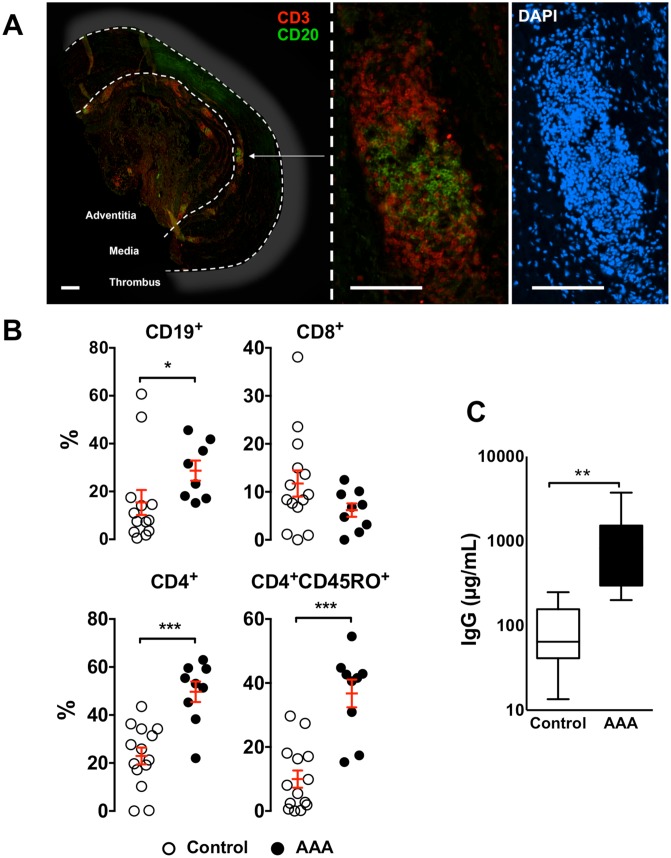
Organized Tertiary Lymphoid Structures in human Abdominal Aortic Aneurysm.(A) Representative immunohistochemical staining of CD3+ T cells (red), CD20+ B cells (green) and nuclei (DAPI, blue) performed on human AAA cross-sections (scale bar = 1 mm). (B) Flow cytometry analysis of the percentage of CD19+ B cells, total CD8+, CD4+and memory (CD4+CD45RO+) T cells in adventitia from AAAs (n = 9) or control aortas (n = 14). (C) Box plot showing the total IgG levels in conditioned medium prepared from adventitial tissues of AAAs (n = 14) and control aortas (n = 5) quantified by ELISA. *, p<0.05; **, p<0.01; ***, p<0.001.